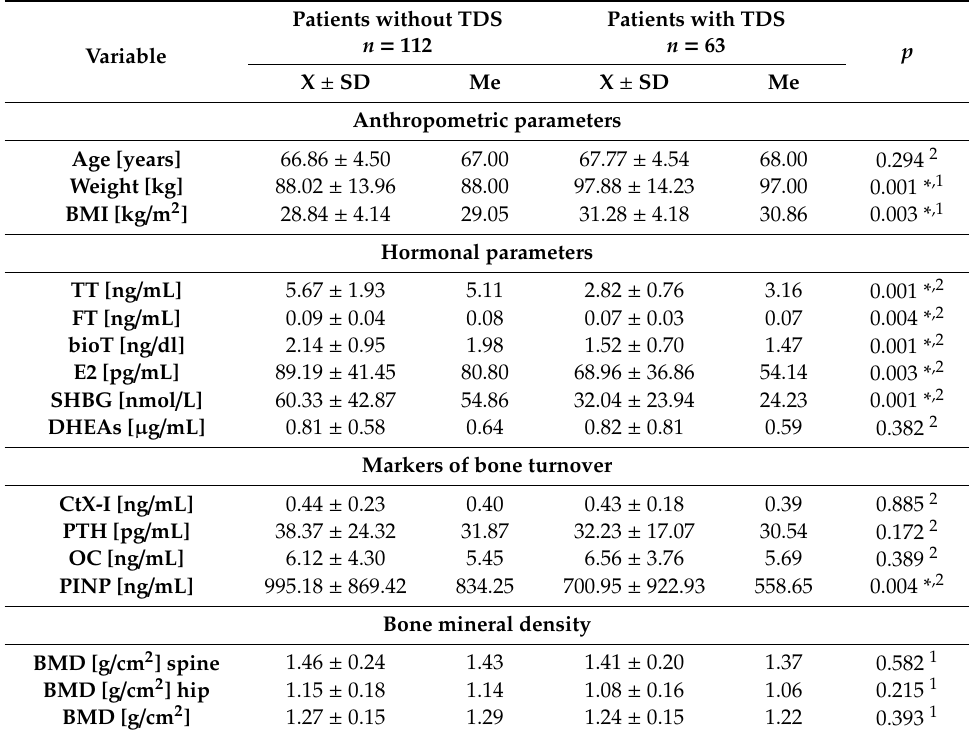
Table 1. Relationship between the biochemical and anthropometric parameters, the levels of selected hormones, and the levels of bone turnover markers in patients with TDS and without TDS. Patients without TDS Patients with TDS n = 112 n = 63 Variable Anthropometric